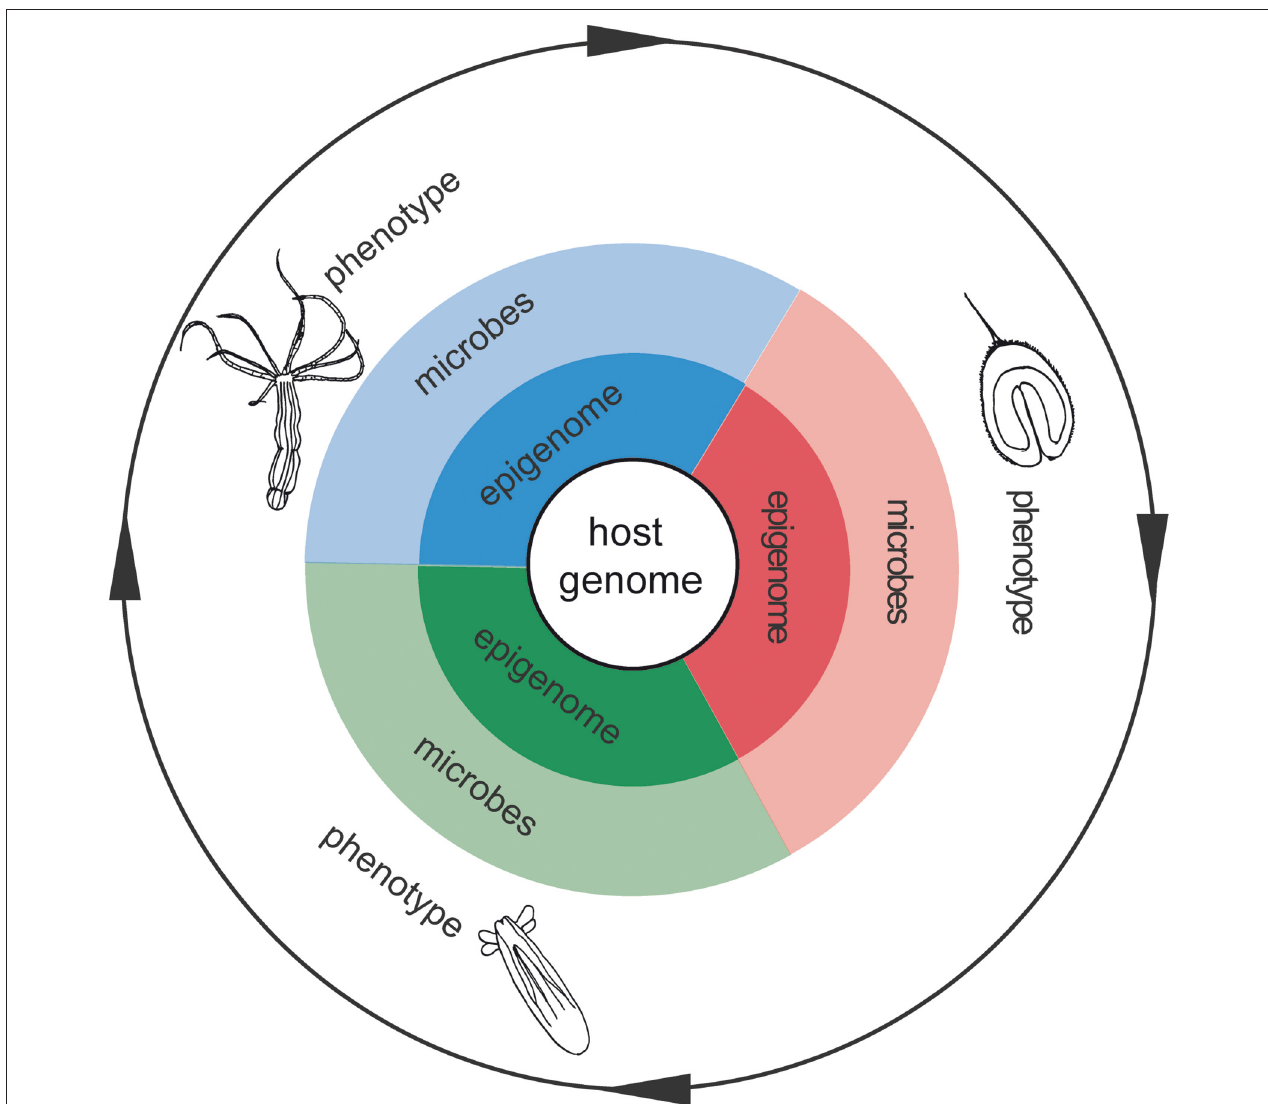
FIGURE 1 | Scheme of factors contributing to the phenotype of an organism in a changing